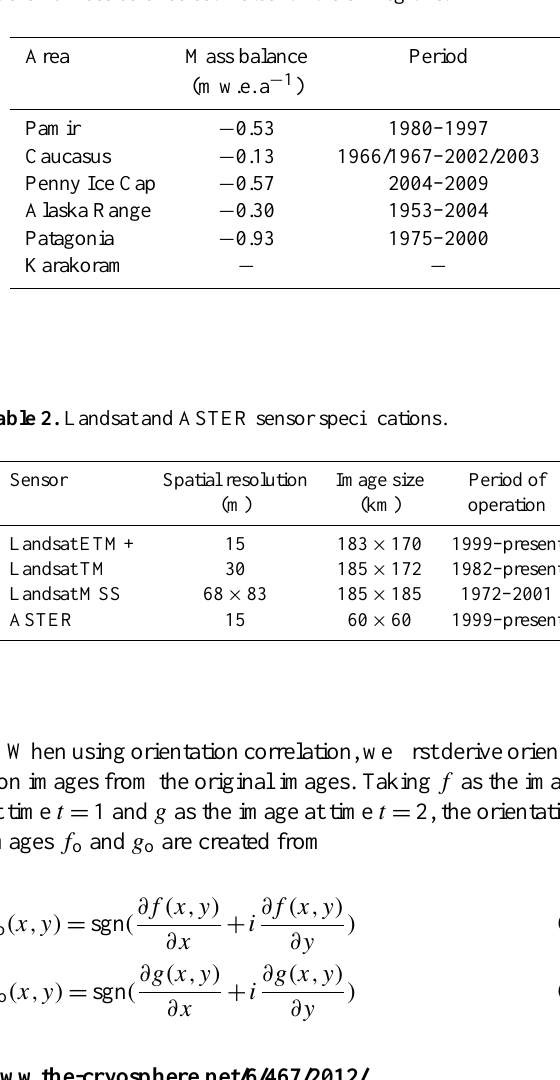
Table 1. Mass balance estimates for the six regions.